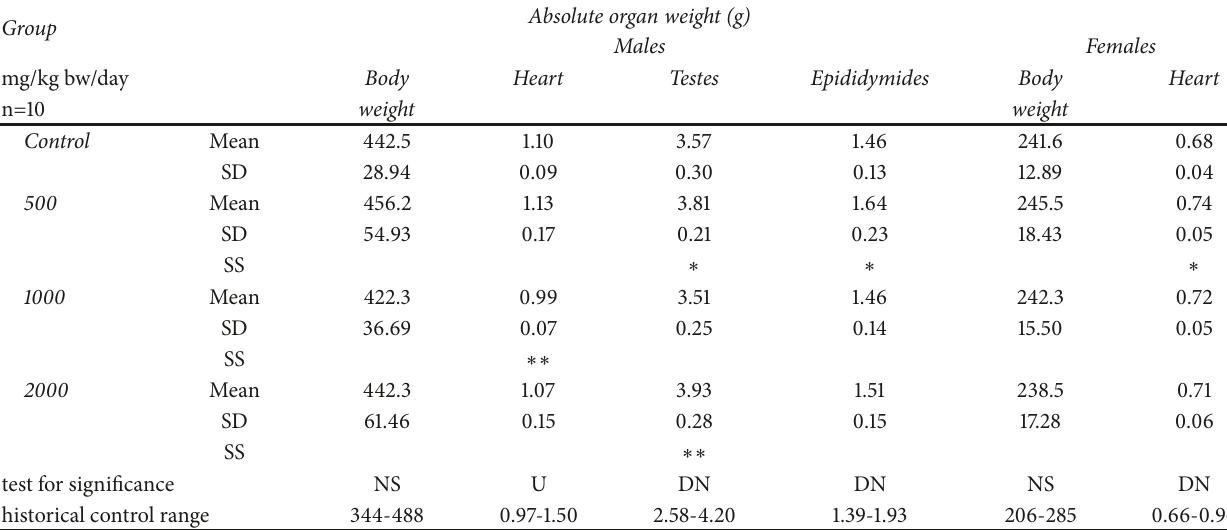
Table 8: Summary of relevant findings for absolute organ weights in male and female rats, 90-day